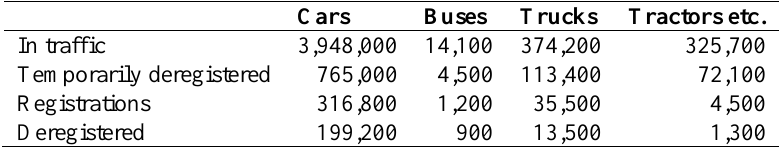
Table 2. Vehicles in Sweden (trailers and motorcycles excluded) Cars Buses Trucks Tractors